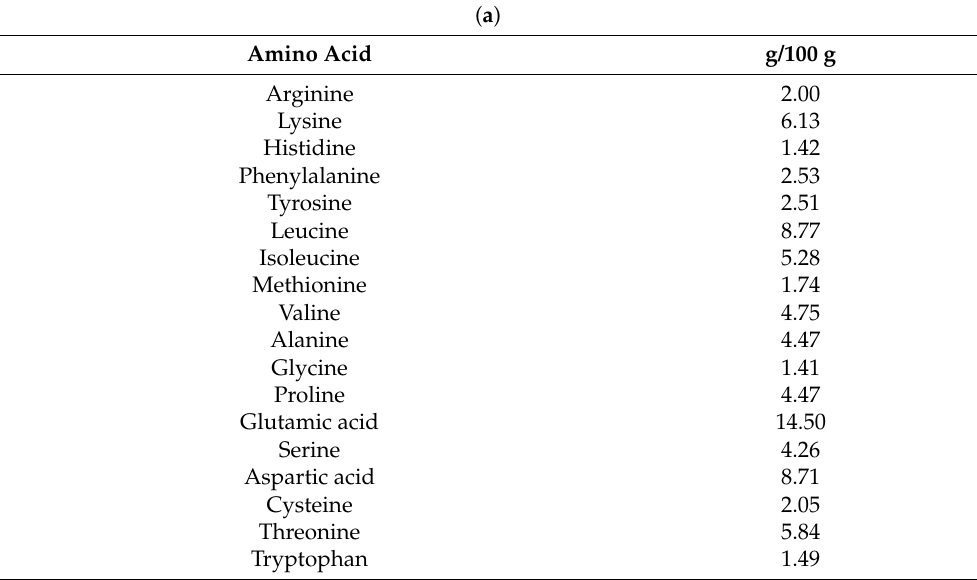
Table 2. Total and essential amino acid content of whey powder (a) and nutritional information of the test solutions